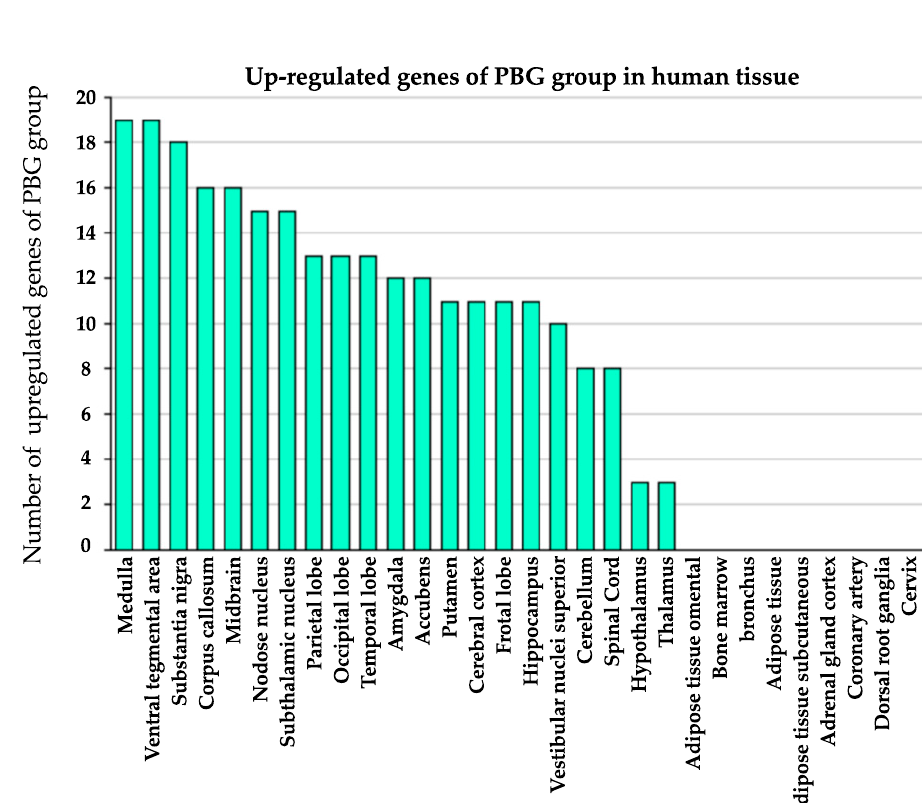
Figure 5. The transcriptome differences of glutamate mediated signal pathway related genes amongst four groups. ( a ) The transcriptional profiles of 75 genes related to the glutamate receptor signal pathway are shown as a heat map. The color key indicates gene expression values. ( b ) Upregulated genes of PBG group in central nerve system that analyzed by ExAtlas gene ontology analysis.